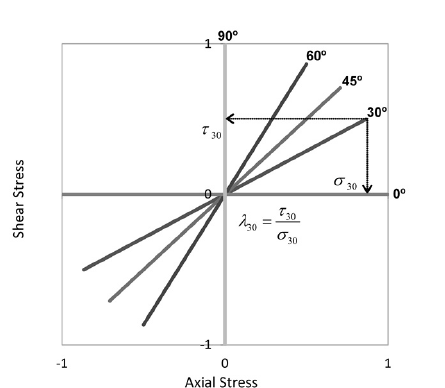
Figure 7: Loading paths used in experiments to calculate the SSF damage